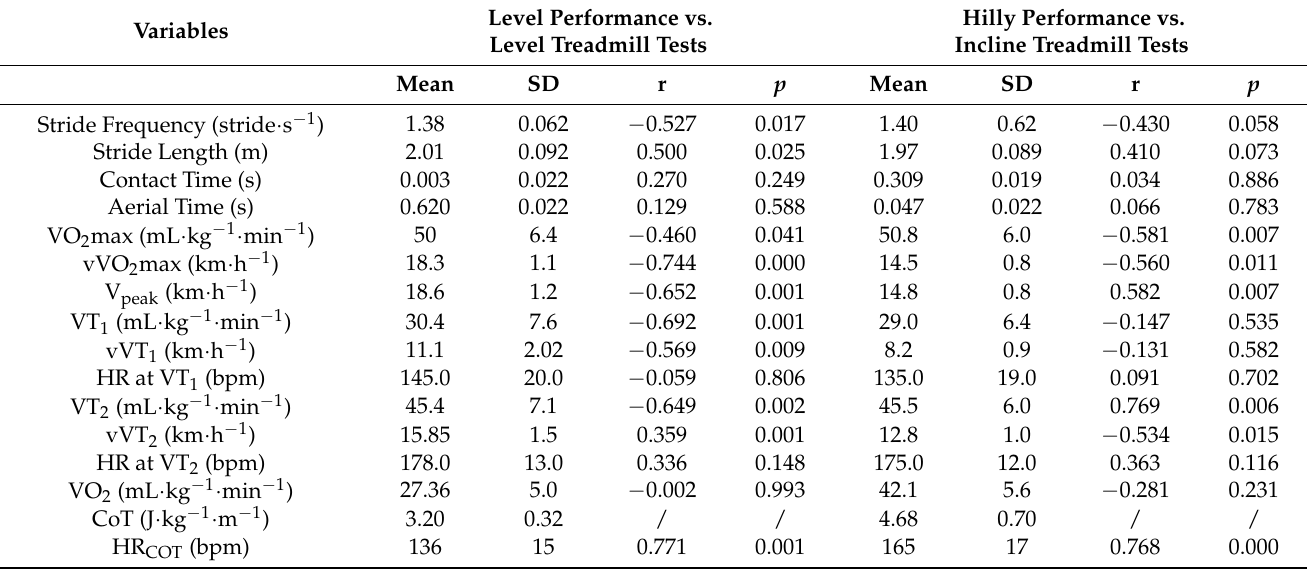
Table 2. Pearson correlation coefficients (r) and p -values ( p ) between level running performance with parameters evaluated at level treadmill (0%, 10 km·h − 1 ), and between hilly running per- formance with parameters evaluated at incline treadmill (7%, 10 km·h − 1 ).